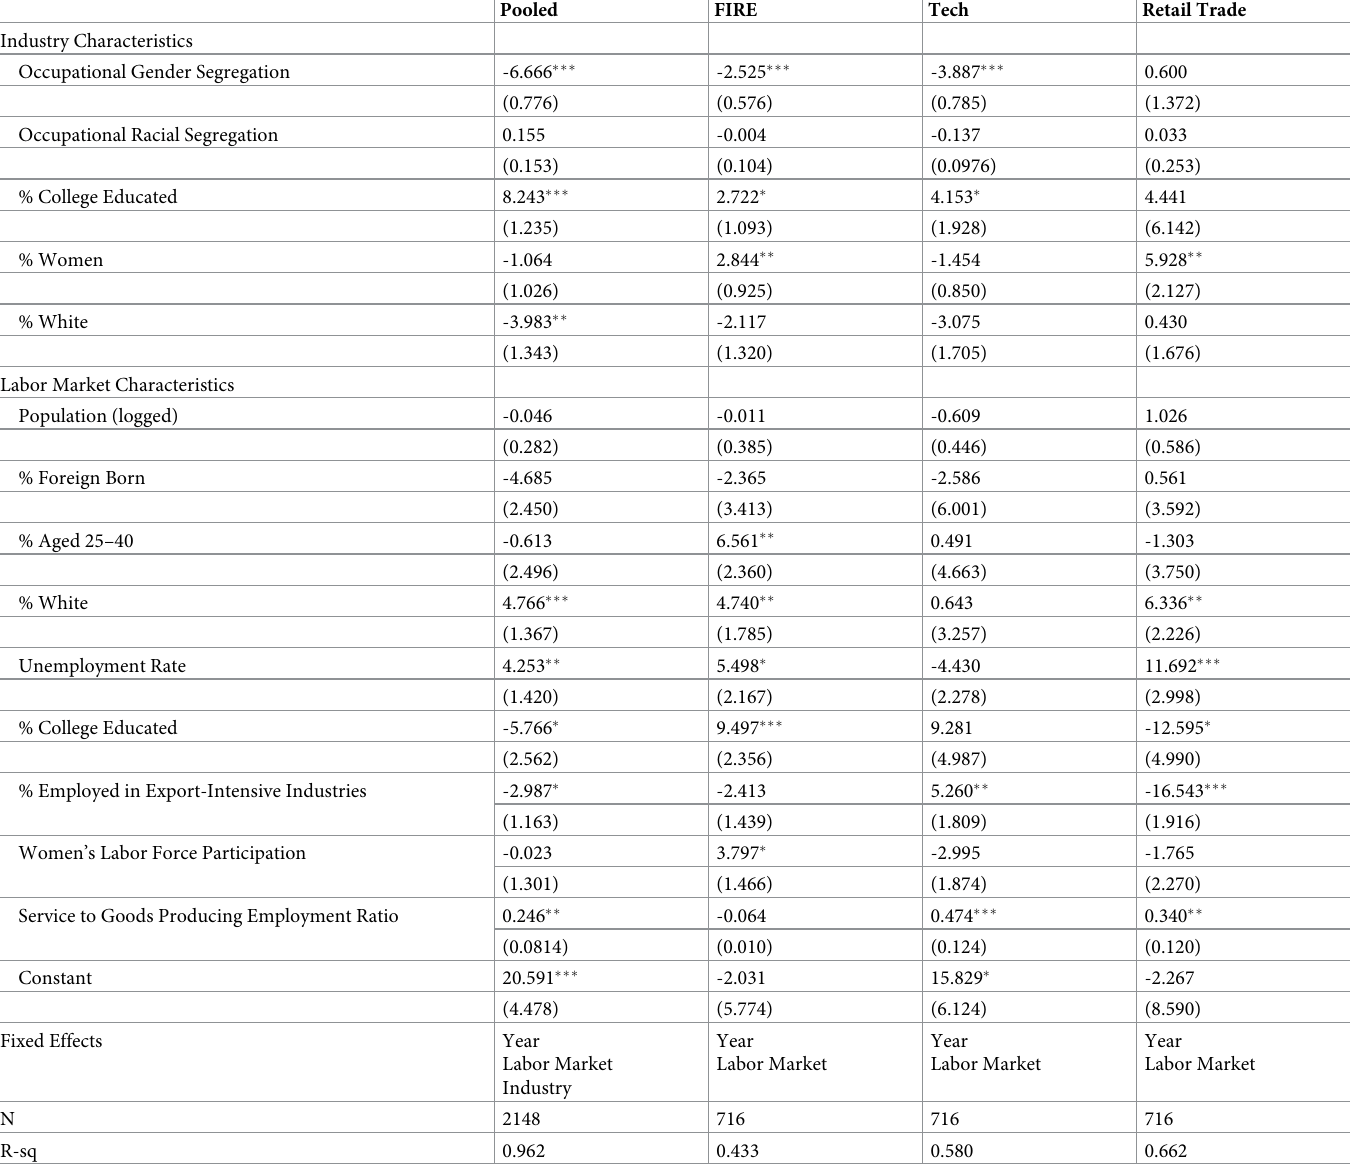
Table 2. Fixed effects models predicting industry expansion (share of employment), 1980–2010. Pooled FIRE